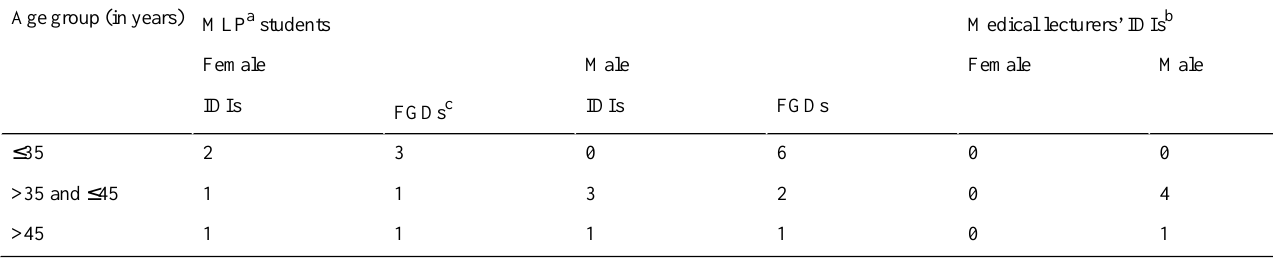
Table 2. Study participants of in-depth interviews and focus group discussions according to age groups and gender.